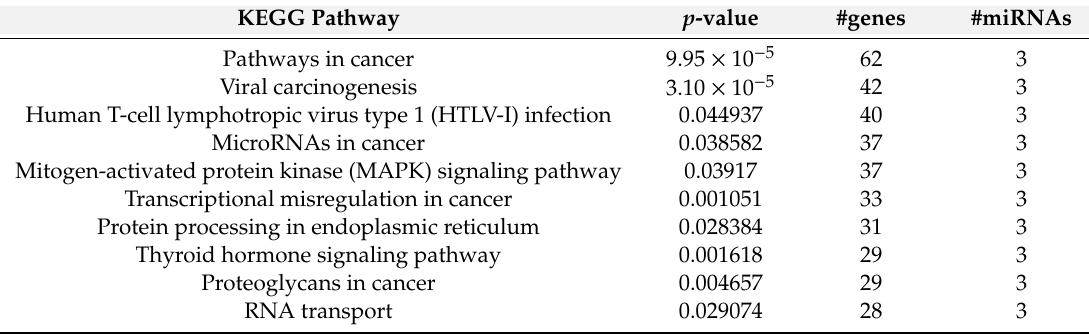
Table 3. Top ten Kyoto Encyclopedia of Genes and Genomes (KEGG) signaling pathway analyses of the four chosen EV-miRNAs. Pathways are listed according to the target-genes (#genes) of the four miRNAs (#miRNAs) analyzed.